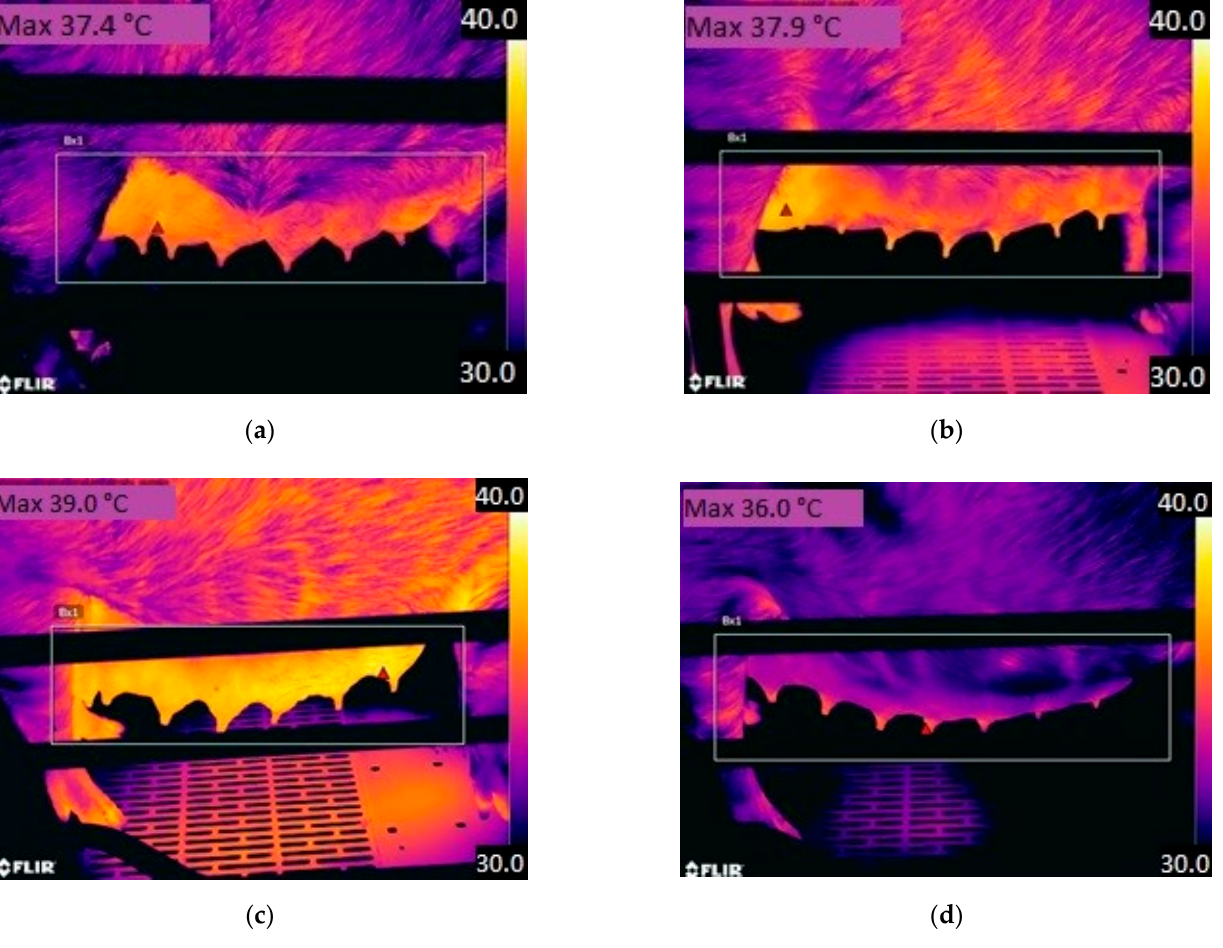
Figure 2. Thermographic images from the right mammary gland of a sow for categories ( a ) healthy; ( b ) clinically suspicious; ( c ) diseased and an image from 2 days before farrowing ( d ). The red triangle within the rectangle in the picture shows the location of the pixel with the highest temperature (see Max temperature top left in the picture).